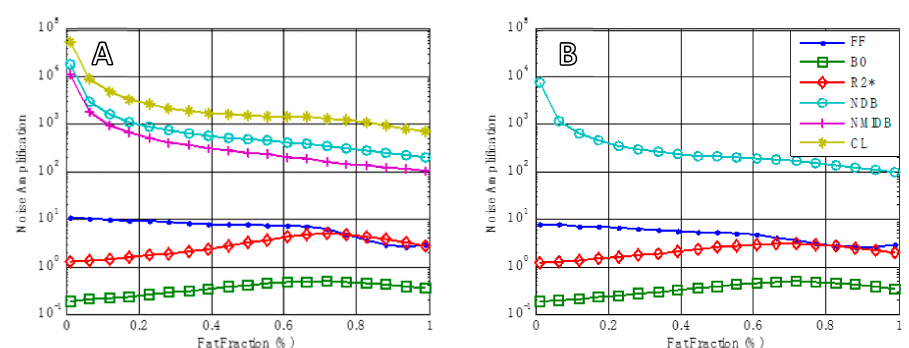
Figure 3. Noise propagation (defined as the standard deviation of the fitted parameter divided by the standard deviation of the noise added to the data points) for key fitted parameters. In panel ( A ), all the fat properties were free parameters, whereas, in panel ( B ), two constraints were used to fix NMIDB and CL in relation to NDB. The NDB is around two orders of magnitude more sensitive to noise than PDFF and noise propagation increases dramatically as PDFF decreases to zero. Using constraints on NMIDB and CL decreases the noise propagation of NDB by a factor of approximately 2.